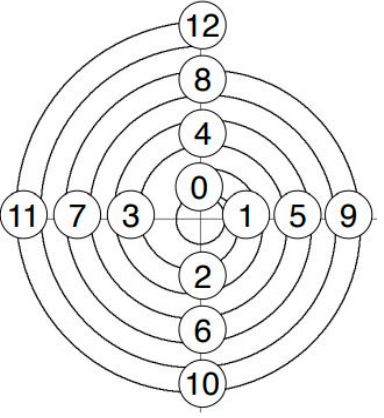
Figure 3. Quadrants of the flow spiral.